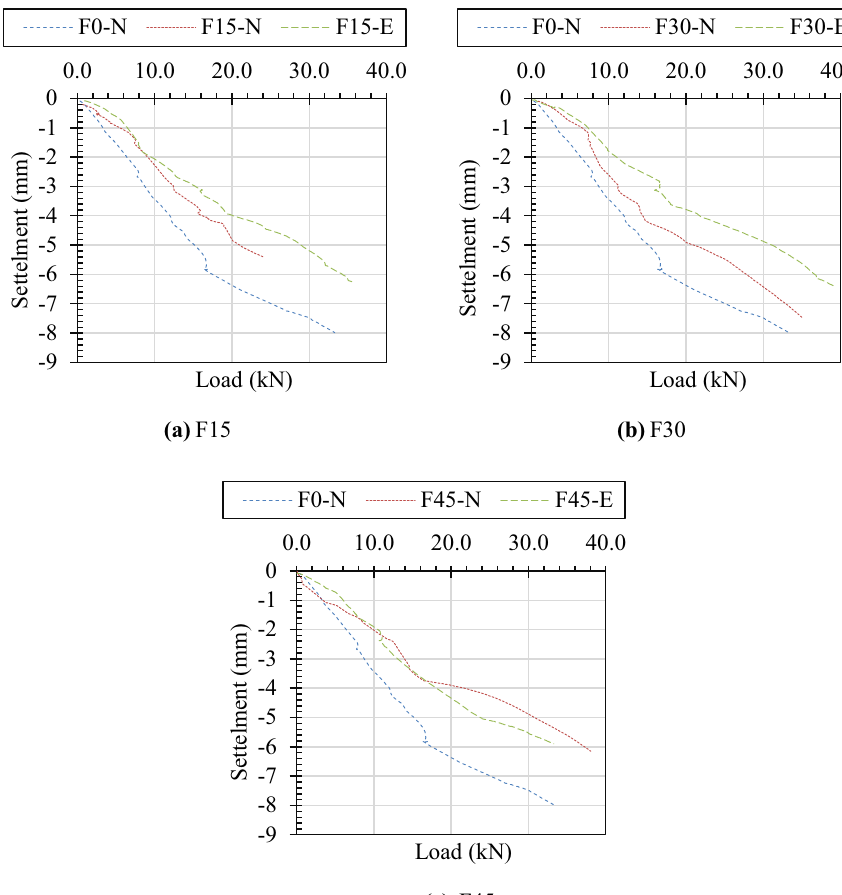
Fig. 12 Load versus settlement measurements for various folded footings ( a ) footing model F15, ( b ) model F30, and ( c ) model